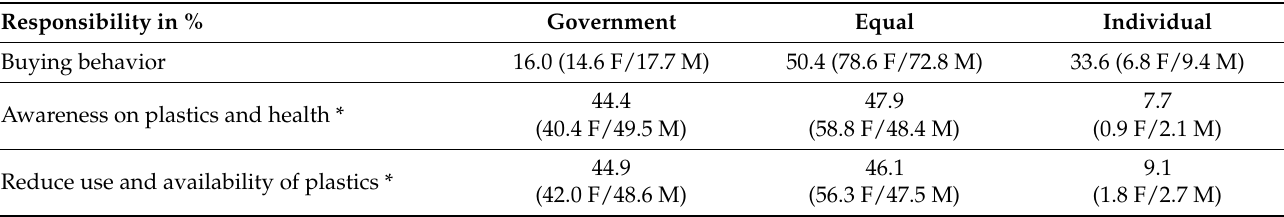
Table 5. Responsibility to reduce plastics: government vs. individual.